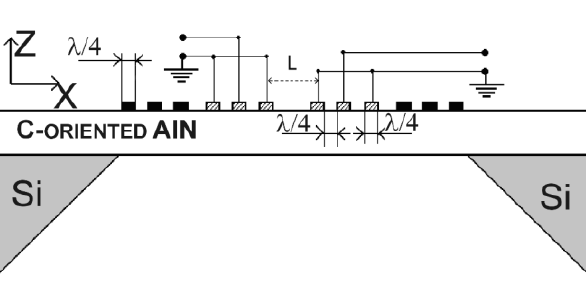
Figure 1. 2 Port FPAR